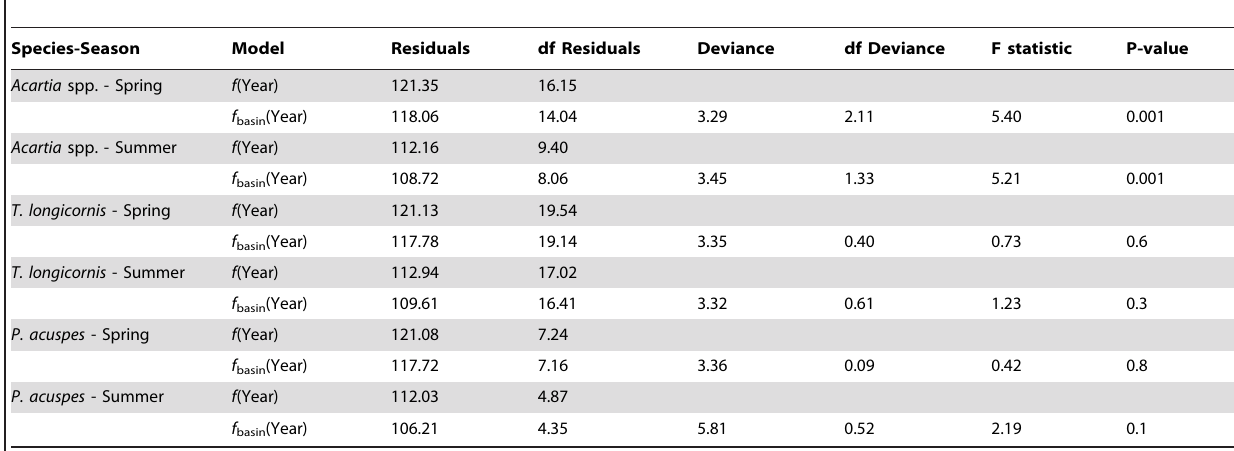
Table 1. Summary of the F-ratio tests comparing species- and season-specific long-term trends modeled across basins or for each basin